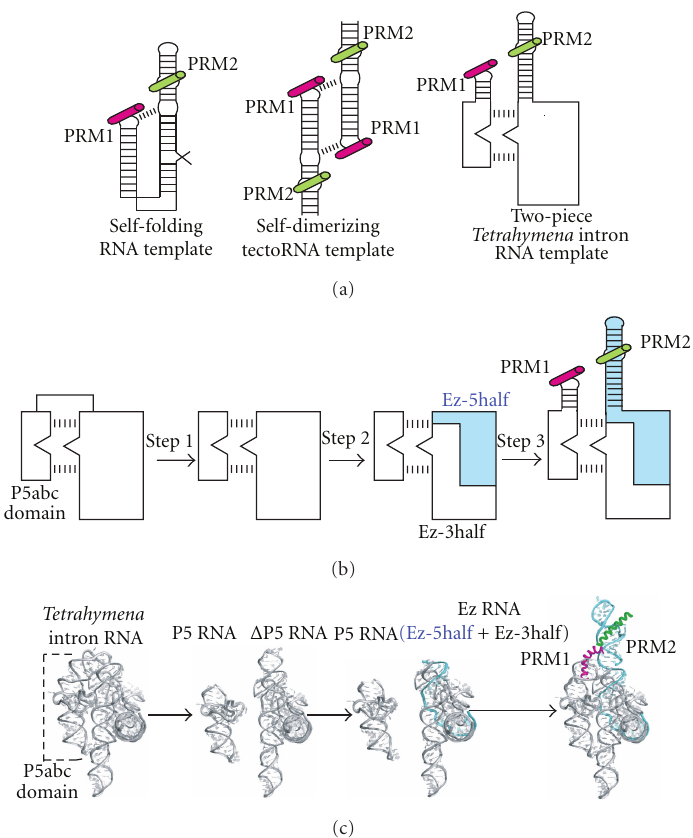
Figure 1: Design of two-piece template RNAs derived from the Tetrahymena intron RNA. (a) Self-folding and self-assembling RNA templates for peptide ligation. Dashed lines indicate tertiary interactions that are crucial for 3D structure formation (left) and self-assembly (middle and right) of RNA templates. The substrate peptide-1 and -2 recognized by PRM-1 and -2 are indicated in red (peptide with C-terminal thioester) and green (peptide with N-terminal cysteine), respectively. (b) and (c) 2D (b) and 3D (c) illustrations of three-step construction of two-piece template RNAs from the Tetrahymena intron RNA. Step 1: the unimolecular Tetrahymena intron (Tet L-30 RNA) was divided into two pieces (P5 RNA and Δ P5 RNA). Step 2: the Δ P5 RNA was divided into two halves (Ez-5half and Ez-3half). Ez-5half is colored pale blue. Step 3: PRM-1 and-2 were added to P5- and Ez-5half,